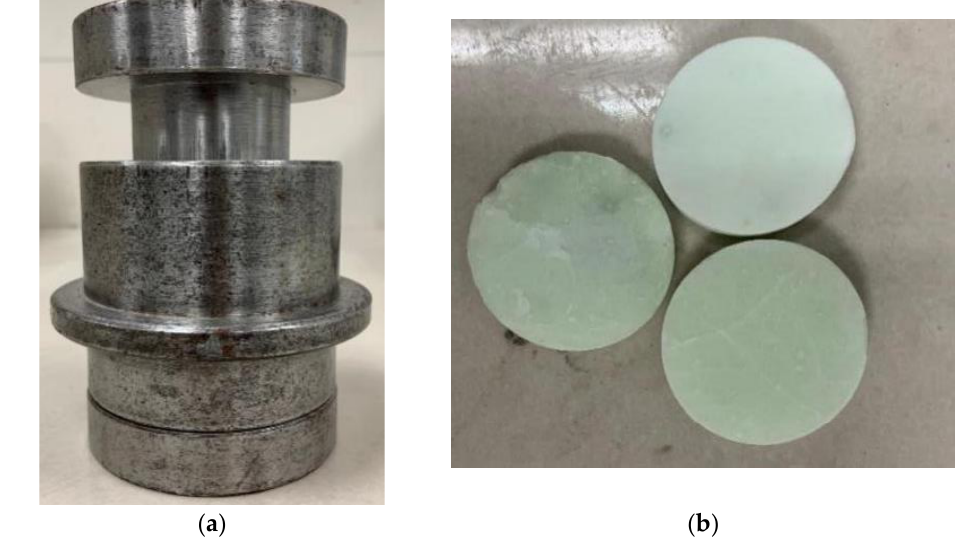
Figure 1. Mold and clinker sample; ( a ) Mold; ( b )